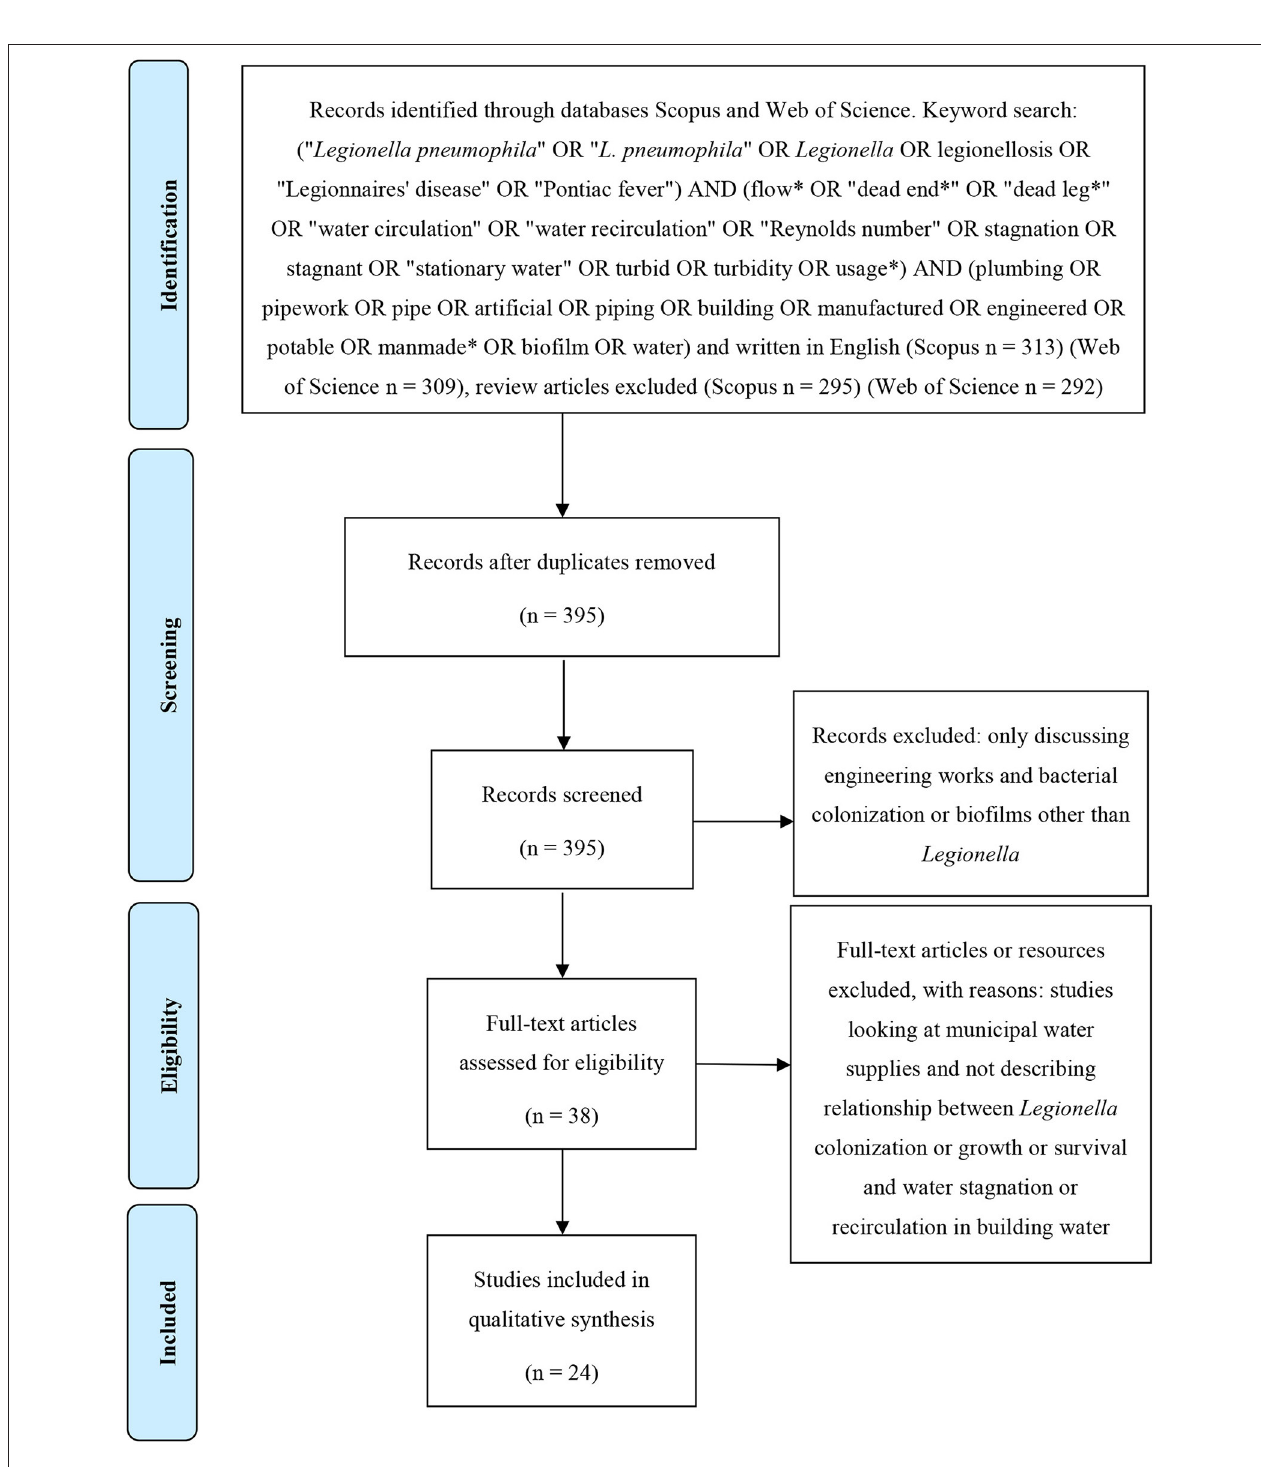
FIGURE 1 | Overview of the PRISMA strategy used for selection of articles.